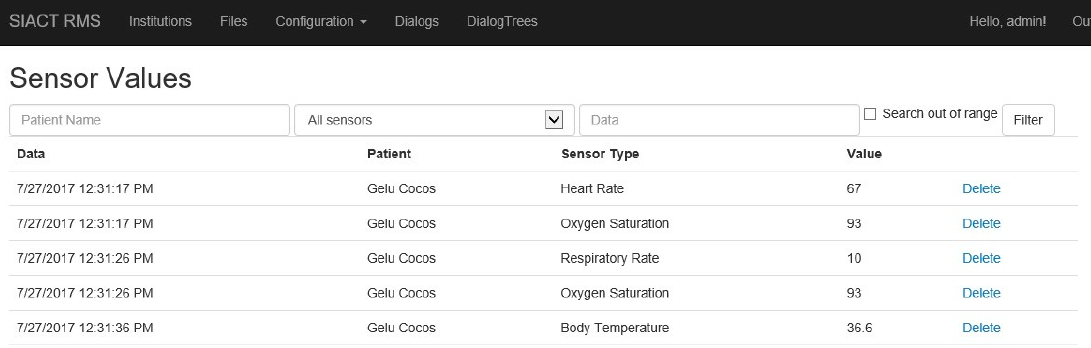
Figure 17. Data values provided by sensors mounted on the patient and recorded in the Server database.